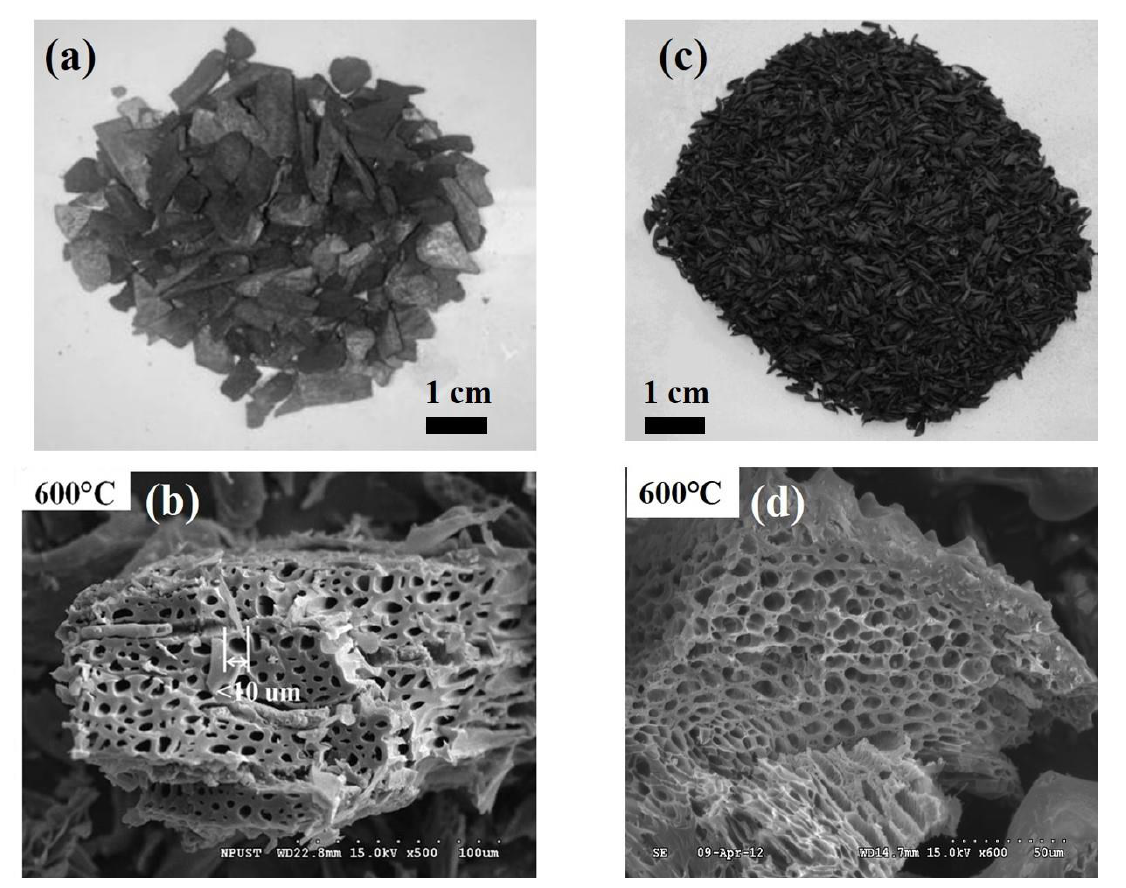
Figure 2. ( a , b ) WB and ( c , d )